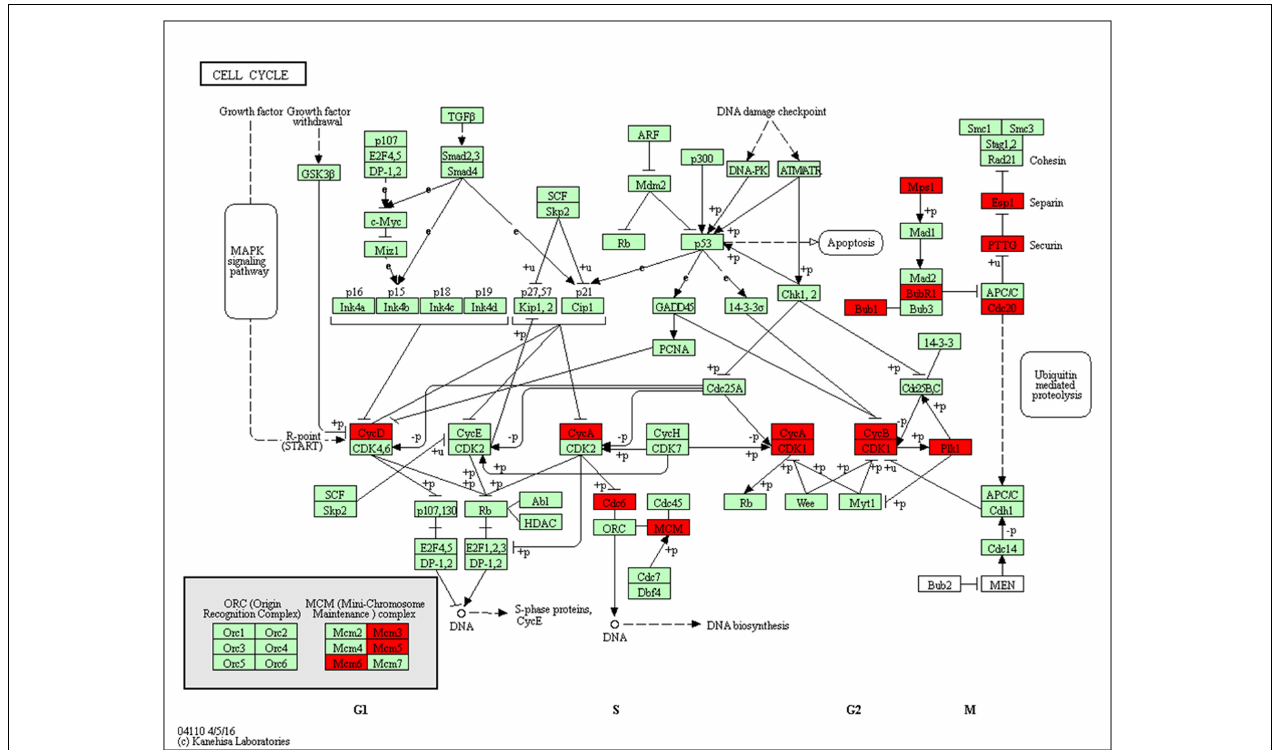
FIGURE 8 | Significantly enriched KEGG pathways in the cell cycle. Up-DEGs are marked in red. The pictures were drawn by KEGG Mapper (www.kegg.jp/kegg/tool/map_pathway2.html).